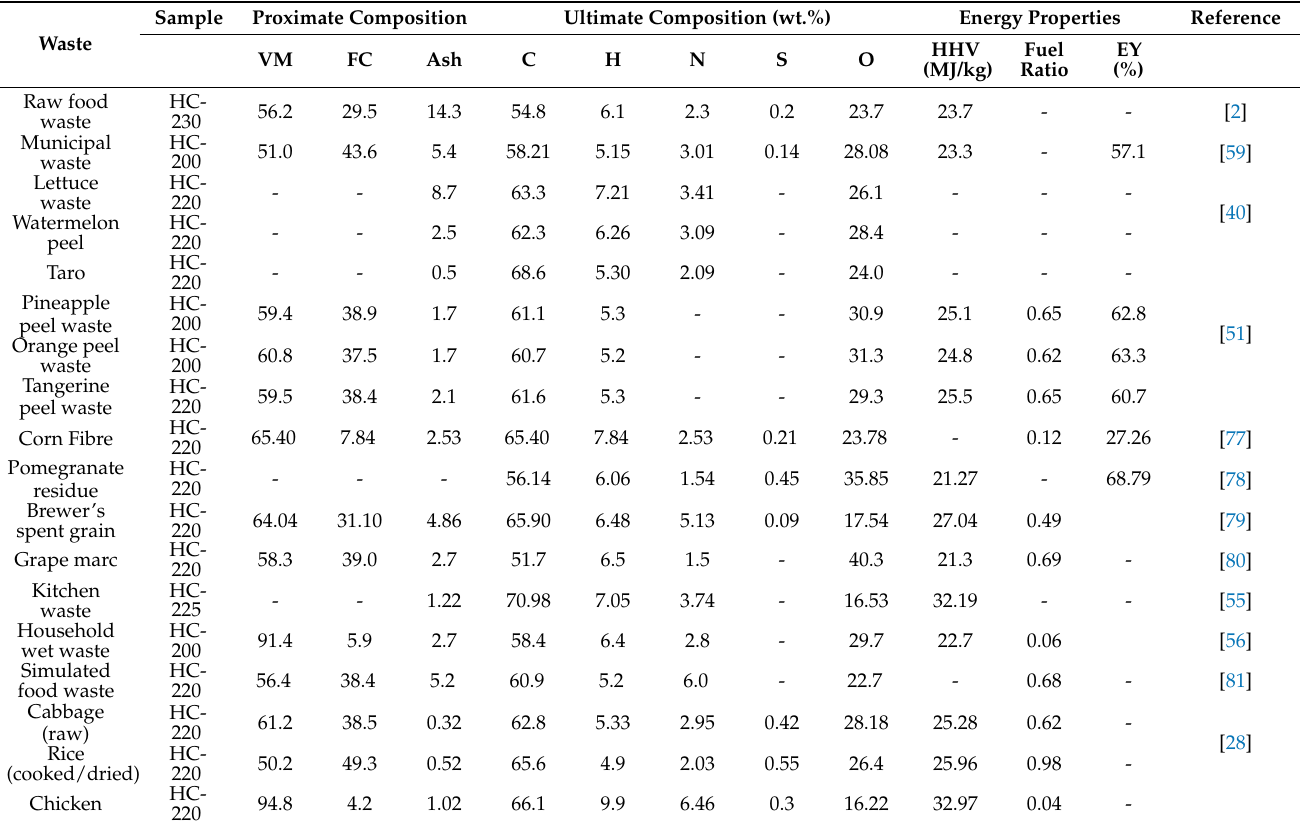
Table 3. Chemical compositions of hydrochars produced from different types of food waste materials (dry and ash-free